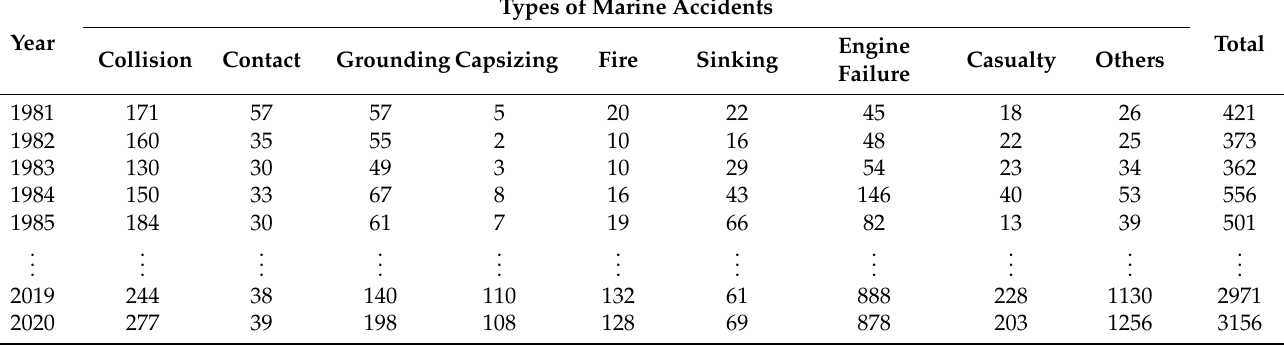
Table 1. Sample of collected raw data.